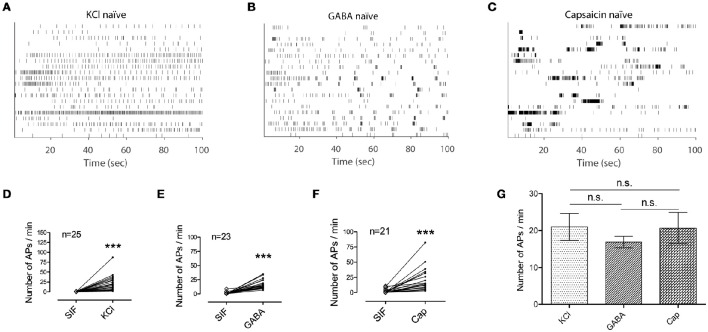
Application of KCl, GABA, or capsaicin clearly activates primary afferents. (A–C) Time stamp of 20 randomly selected single fibers from each group of chemical responses i.e., KCl (n = 25) in (A), GABA (n = 23) in (B), capsaicin (n = 21) in (C). (D–F) Spike counts from each single fiber during the control period of synthetic interstitial fluid (SIF) and the corresponding responsive period to a stimulant. (Wilcoxon signed rank test, ***P < 0.001) (G) Mean of the spike counts in the evoked responses for KCl, GABA, and capsaicin are compared. (Kruskal-Wallis one-way ANOVA, n.s., not significant. Error bars represent s.e.m.).